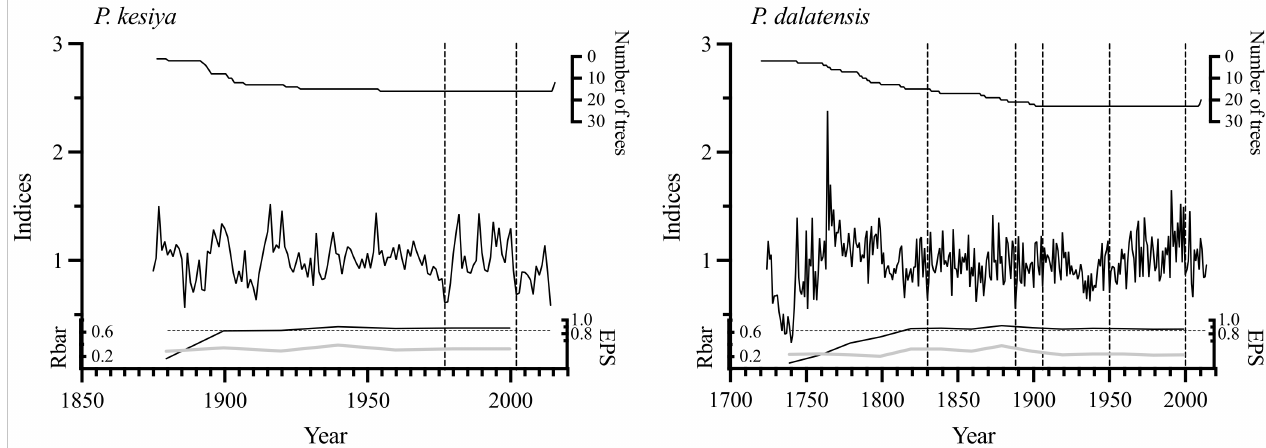
Figure 1. Chronologies of tree-ring indices of the two pine species. The vertical dashed lines indicate marker years (reduced growth). In the lower parts of the panels, the series of Rbar values are drawn in grey, and the series of EPS values, in